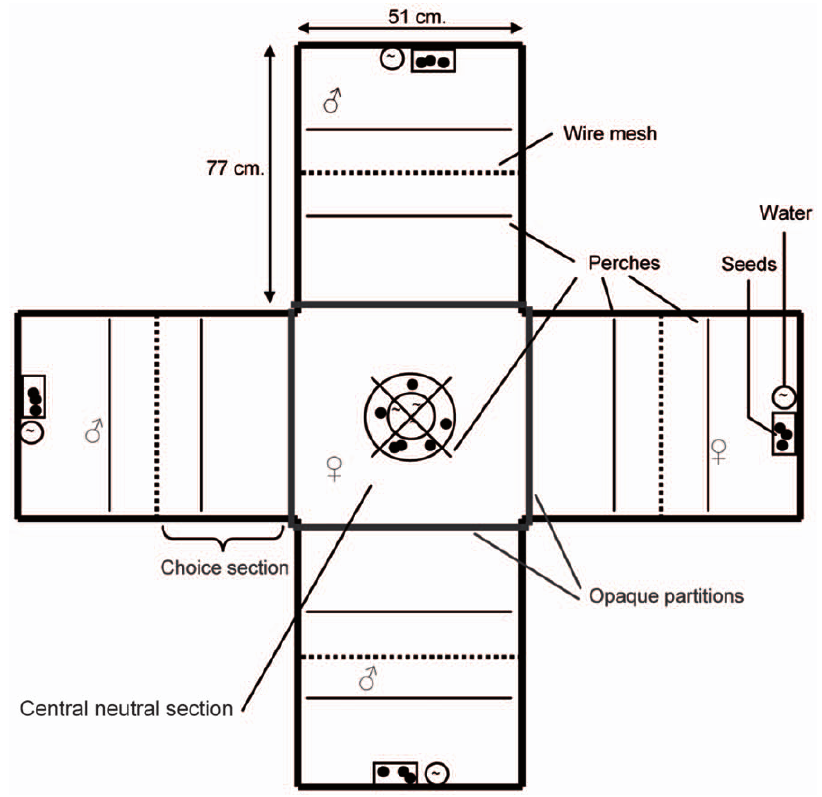
Figure 1. Four-chamber choice-apparatus as seen from above.